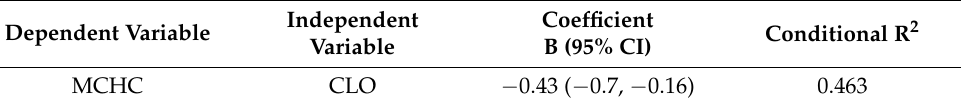
Table 4. Bayesian generalised linear regression analysis of the association between concentrations of clothianidin (CLO) and the mean corpuscular haemoglobin concentration (MCHC) among male farmworkers ( n =